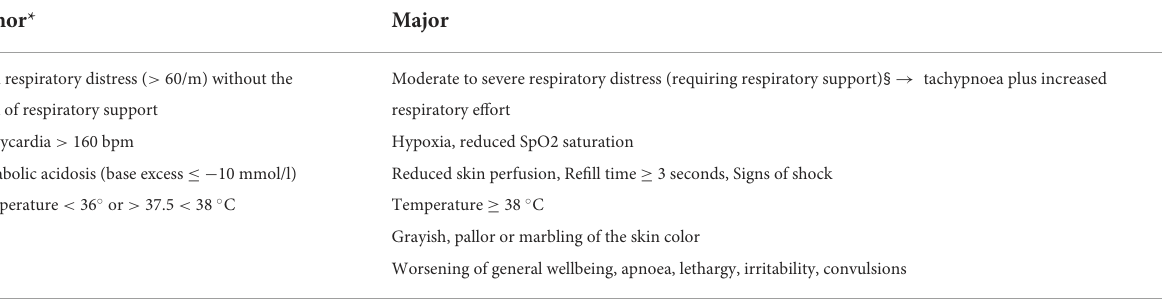
TABLE 1 Symptoms and classification of infant’s clinical presentation according to serial clinical observation and neonatal sepsis calculator. (A) Minor and major clinical symptoms and criteria suggesting observation or laboratory evaluation and antibiotic treatment [modified from Berardi et al. (14)].